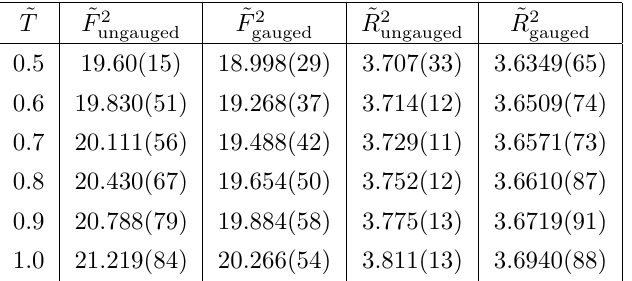
Table 2. Data for the potential energy term ~ F 2 and the extent of space ~ R 2 of the ungauged and gauged theories in the large- N continuum